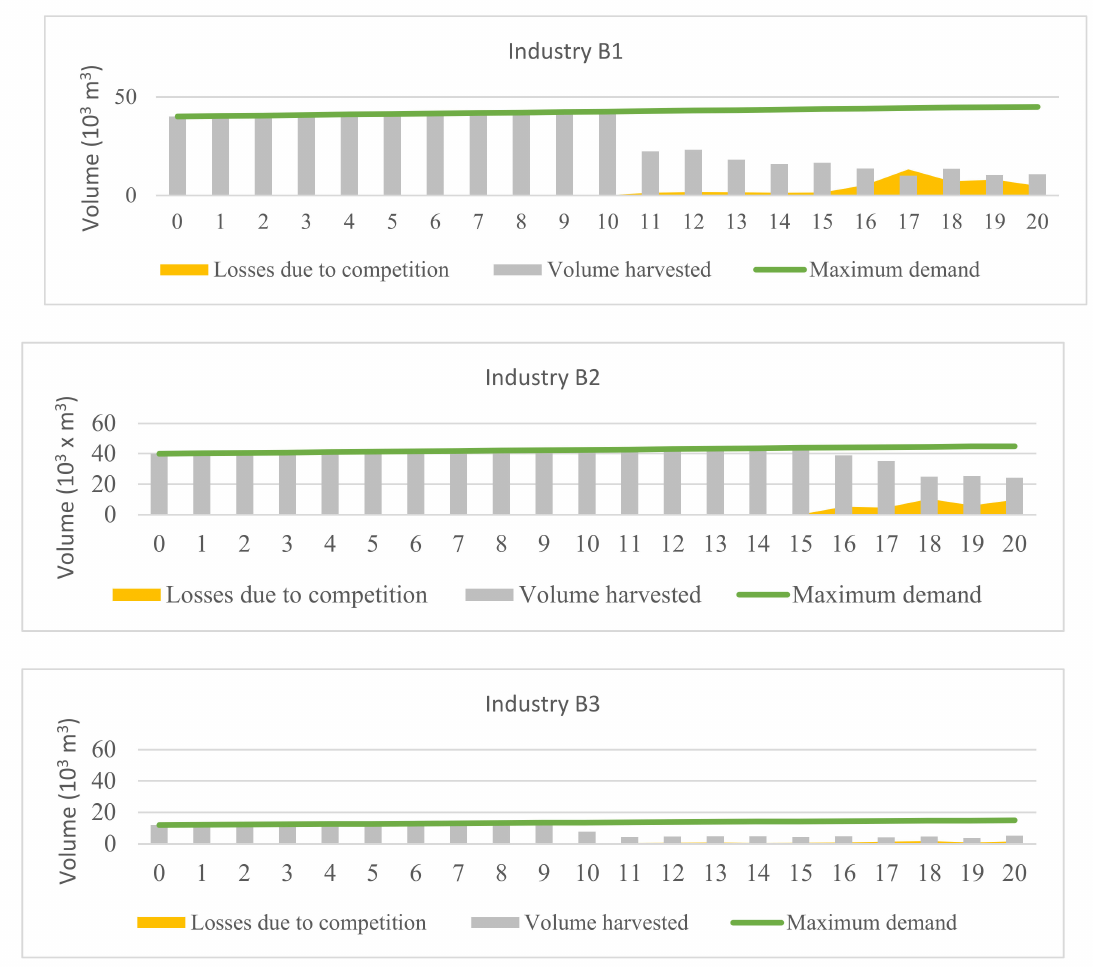
Figure 8. Results of simulation for Scenario 3 in terms of volume extracted by each of the industrial activities comprised ( B1 , B2 , B3 ) with indication of maximum volume goals and volume lost due to competition among industries. The charts show that demand decreases after simulation year 10 (9 for B3) indicating that the maximum volume goal was too optimistic and must be adjusted in the next step of the